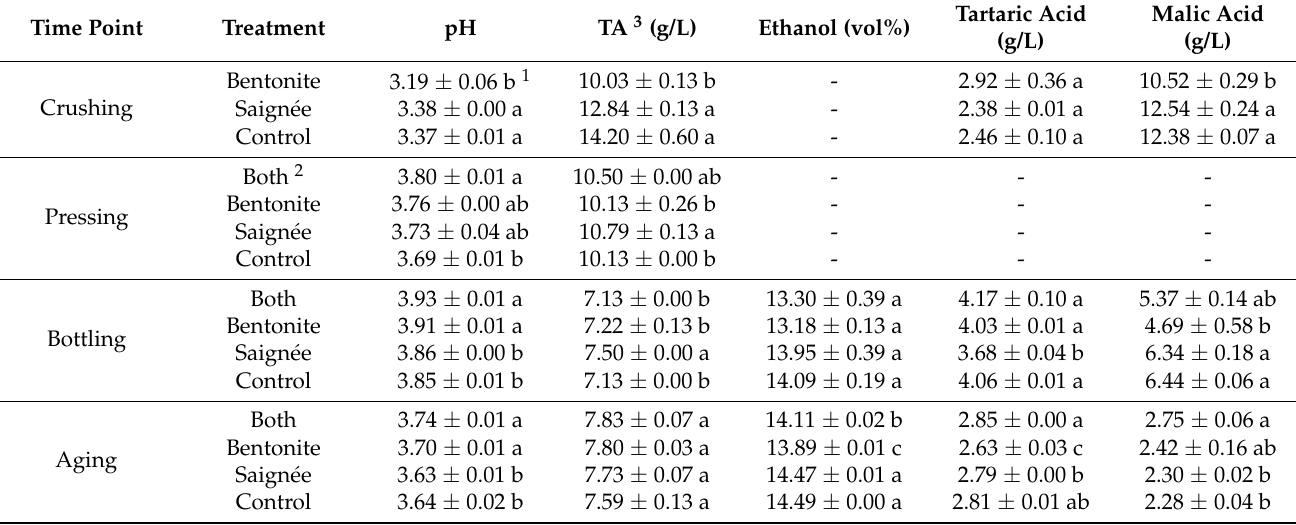
Table 1. Basic chemical properties of the Marquette grape musts and wines at four time points (crushing, pressing, bottling, 5 months aging) after different treatments. Data were expressed as mean of replicate ( n = 2) ± standard